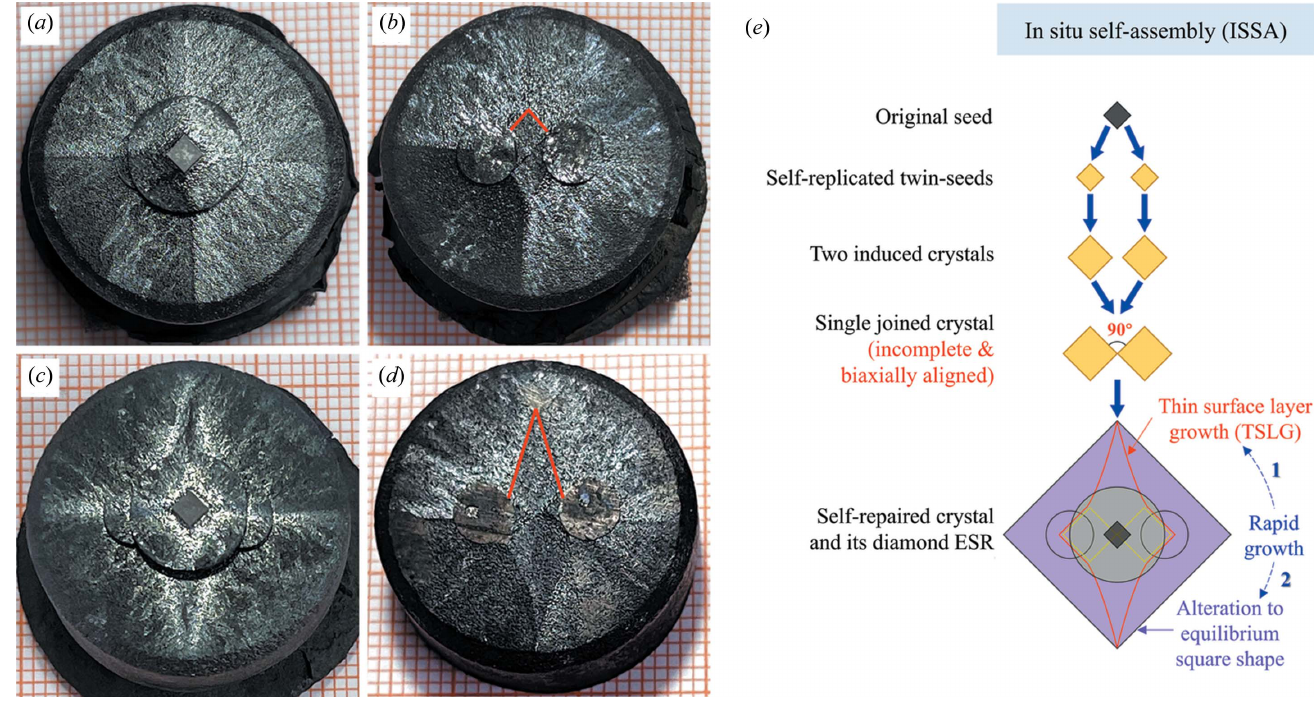
Figure 4 Photographs of two fully grown YBCO crystals (on millimetre square graph papers) processed by ISSA seeding: top views ( a ) and ( c ) before and ( b ) and ( d ) after splitting off their seeding constructions. Distances between mini-buffers ( D ) are 7 and 10 mm for samples in ( a ) and ( c ), respectively. ( e ) Schematic illustration of the route of ISSA seeded YBCO growth.